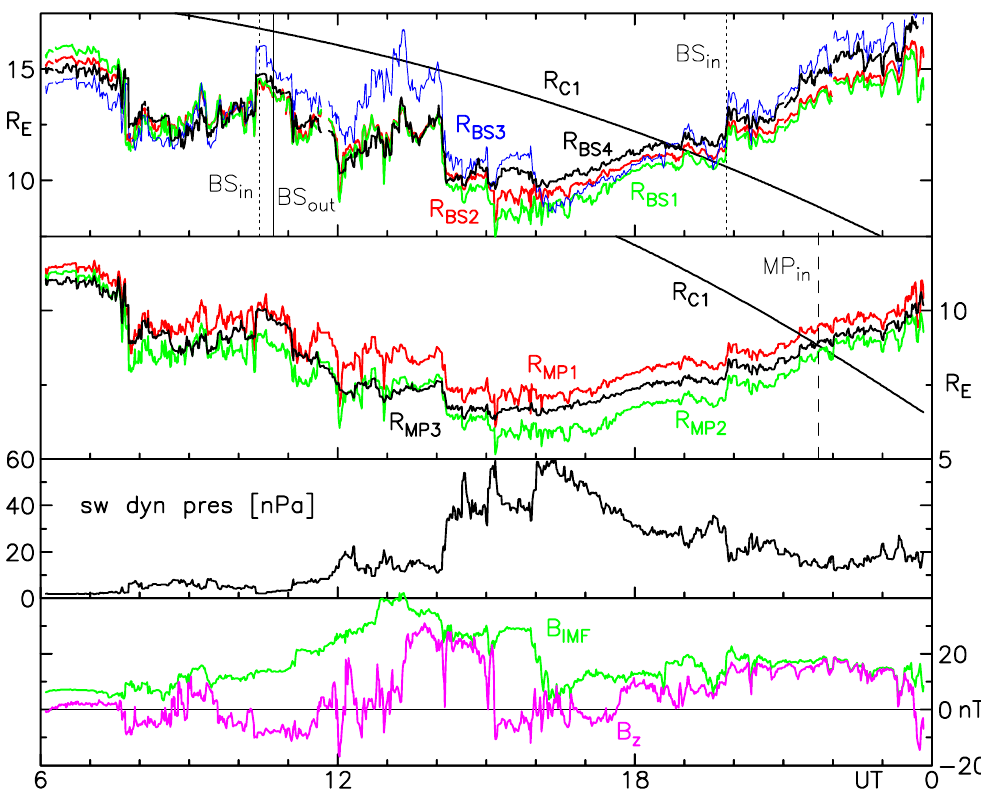
Fig. 4. 17 January 2005. Top panel: model bow shock locations for angular directions corresponding to Cluster 1 position ( R C1 black line): BS1 in green (Farris et al., 1991; Farris and Russell, 1994), BS2 in red (Cairns et al., 1995; Farris and Russell, 1994), BS3 in blue (Jerab et al., 2005), and BS4 in black (Verigin et al., 2001a,b, 2003). Observed bow shock crossings are marked by vertical lines (inbound dotted, outbound solid) at 10:25, 10:42, and 19:51UT. Panel 2: model magnetopause locations for Cluster 1 angular directions: MP1 in red (Shue et al., 1998), MP2 in green (Lin et al., 2010), and MP3 in black (new model). Observed magnetopause crossing at 21:43UT is marked by dashed line. Panel 3: solar wind dynamic pressure. Bottom panel: IMF total value (green) and B z (lilac). Interplanetary data from Wind